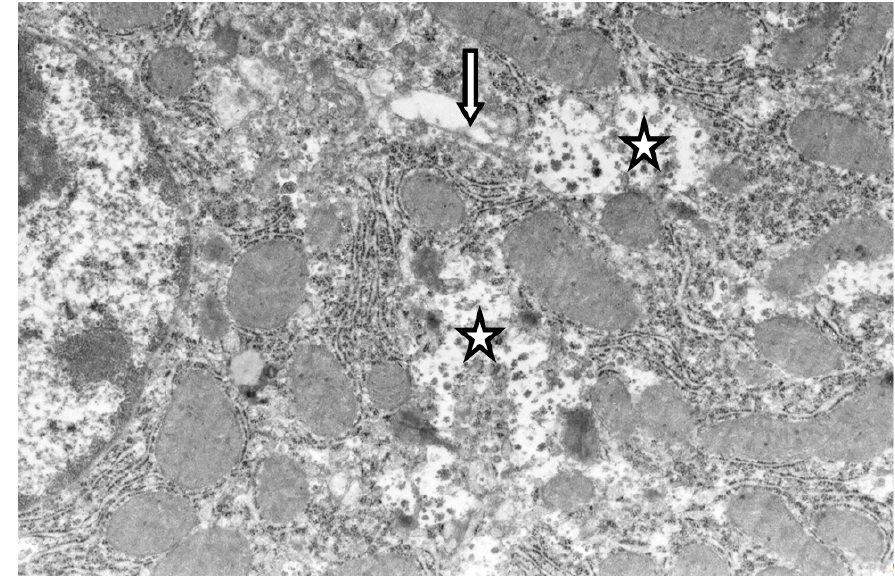
Figure 1. Fragment of hepatocyte cytoplasm of mice liver, 24 h after the single mannan A administration (50 mg / kg). Enlarged cisterns of the Golgi complex (arrow); decreased number of rosette of glycogen (stars). Magnification 6000 × . All the experimental procedures were carried out in accordance with the guidelines of the NIH Guide for the Care and Use of Laboratory Animals and were approved by the